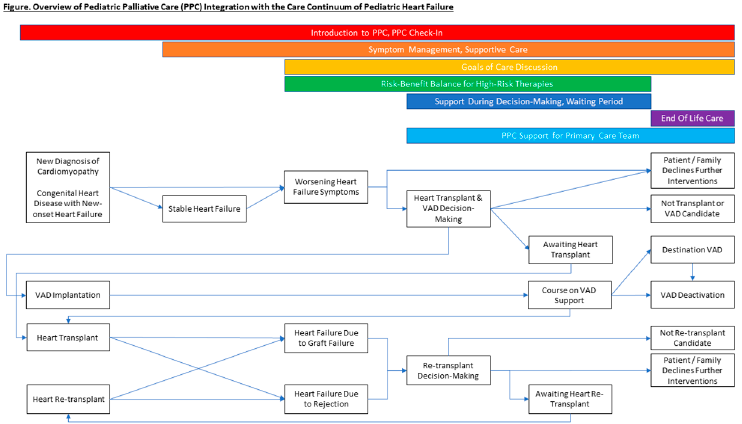
Figure 1. Pediatric palliative care throughout the continuum of pediatric heart failure and trans-